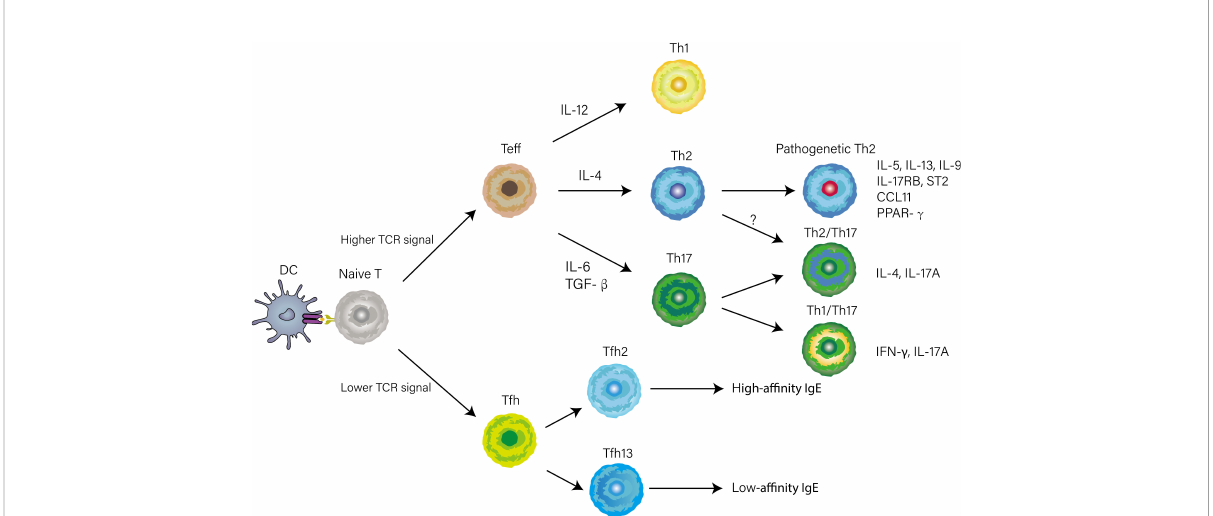
FIGURE 1 CD4 + T cells differentiation and heterogeneity in the context of asthma. The early differentiation is primed by antigen presentation of DCs in lymphoid tissue. Whether naïve T cell differentiates into Tfh or Teff cell is determined by TCR signal strength. When stimulated by a high TCR signal, naïve T cells differentiate into Teff cells. Concurrently, Innate cytokines direct functionally distinct effector programs (e.g., Th1, Th2, and Th17) by inducing lineage-de fi ning transcriptional networks. Several phenotypically and functionally CD4 + T cells have recently been identi fi ed based on the expression of cytokines, transcription factors, or surface